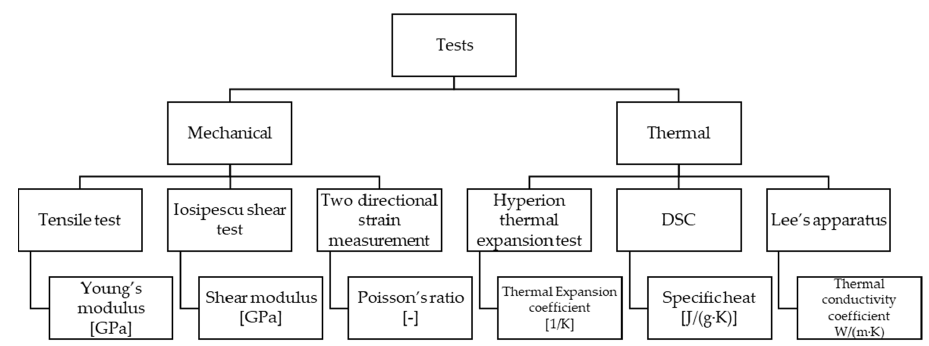
Figure 6. Material identification test summarization.